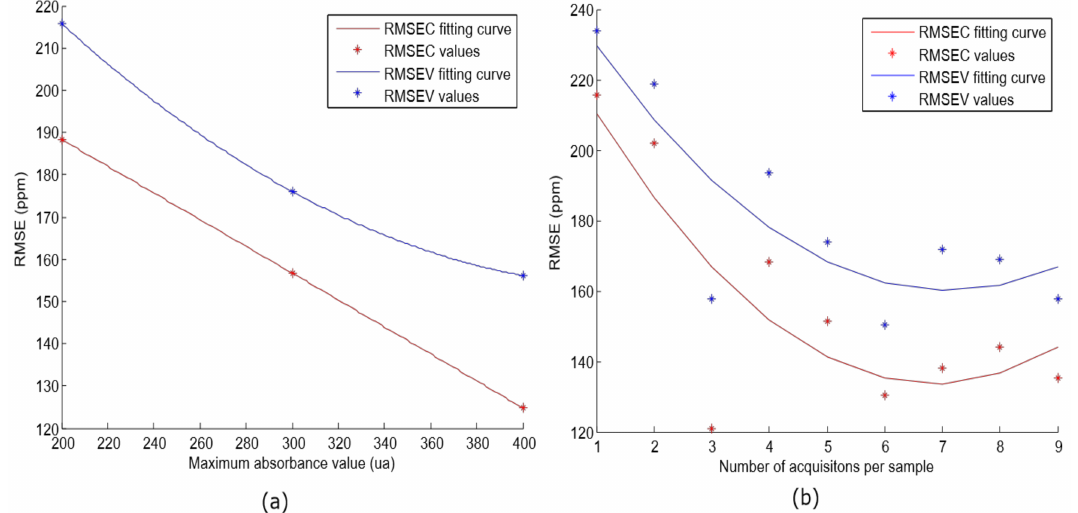
Figure 8. ( a , b ) show the RMSEC and RMSEV values when different sets of samples were employed and different numbers of acquisitions per sample were averaged,